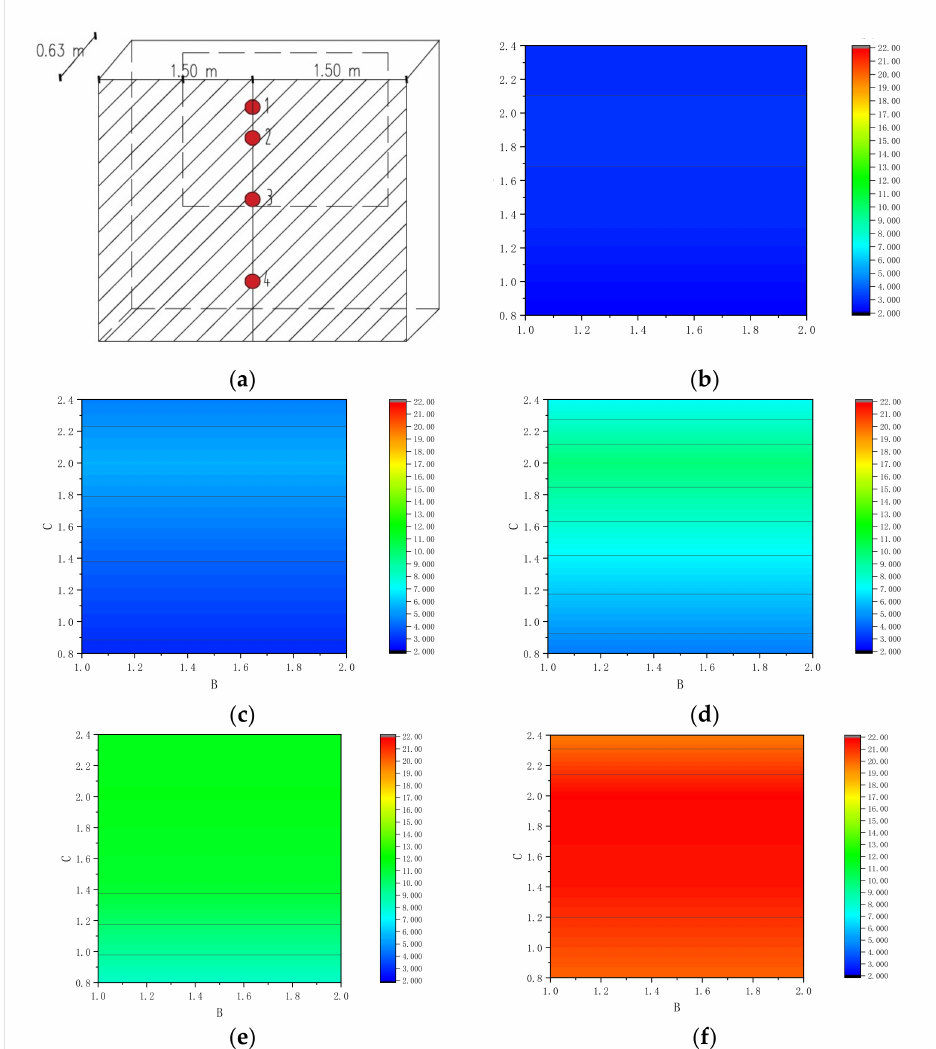
Figure 11. Longitudinal distribution map of the morning sunspace’s thermal environment on 28 Jan- uary; ( a ) Attached sunspace’s longitudinal section of temperature field; ( b ) Distribution of tempera- ture field at 8:30; ( c ) Distribution of temperature field at 9:00; ( d ) Distribution of temperature field at 9:30; ( e ) Distribution of temperature field at 10:00; ( f ) Distribution of temperature field at